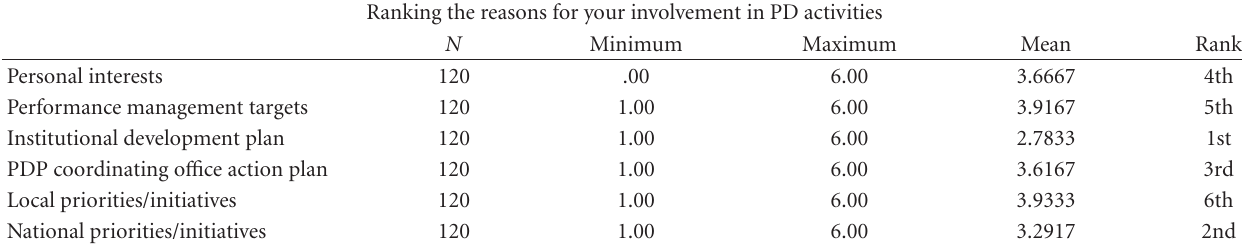
Table 10: Teachers justification of their involvement in range of PD